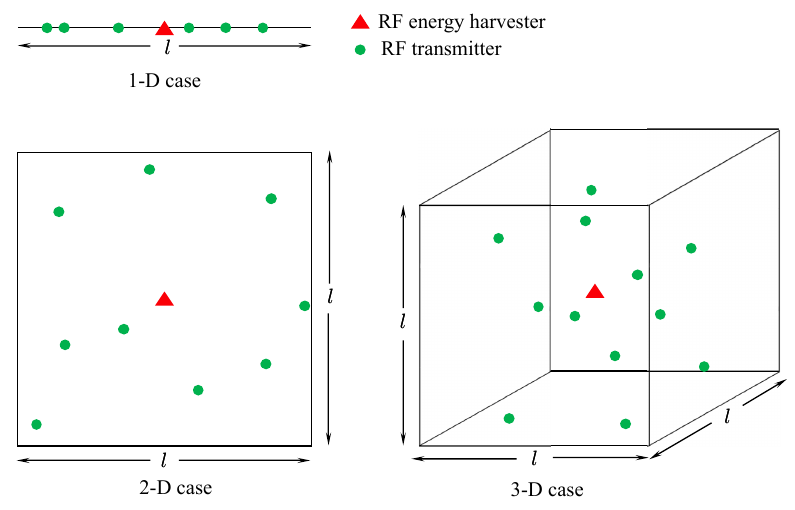
Figure 1. Spatial model of d -dimensional networks for d = 1,2 and